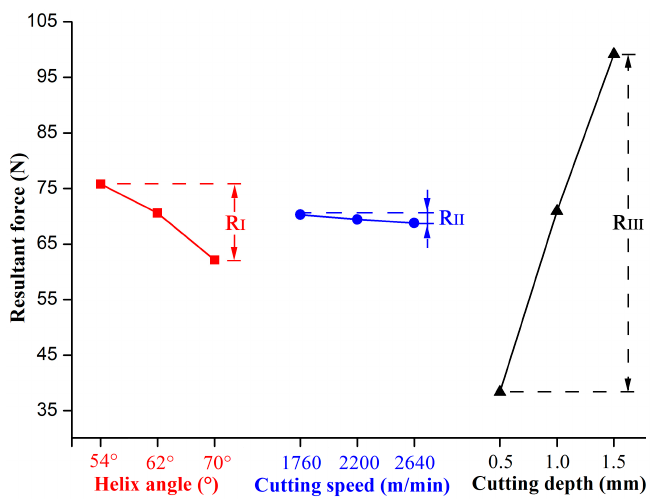
Figure 2. Influence of cutting conditions on resultant force.